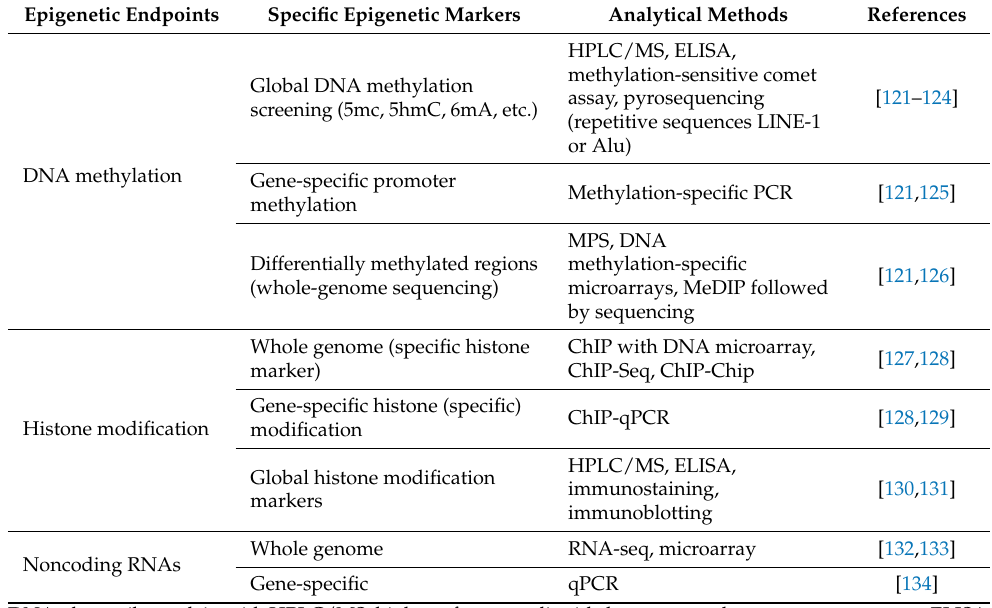
Table 3. Common methodologies for epigenetic endpoints applied for nanomaterial